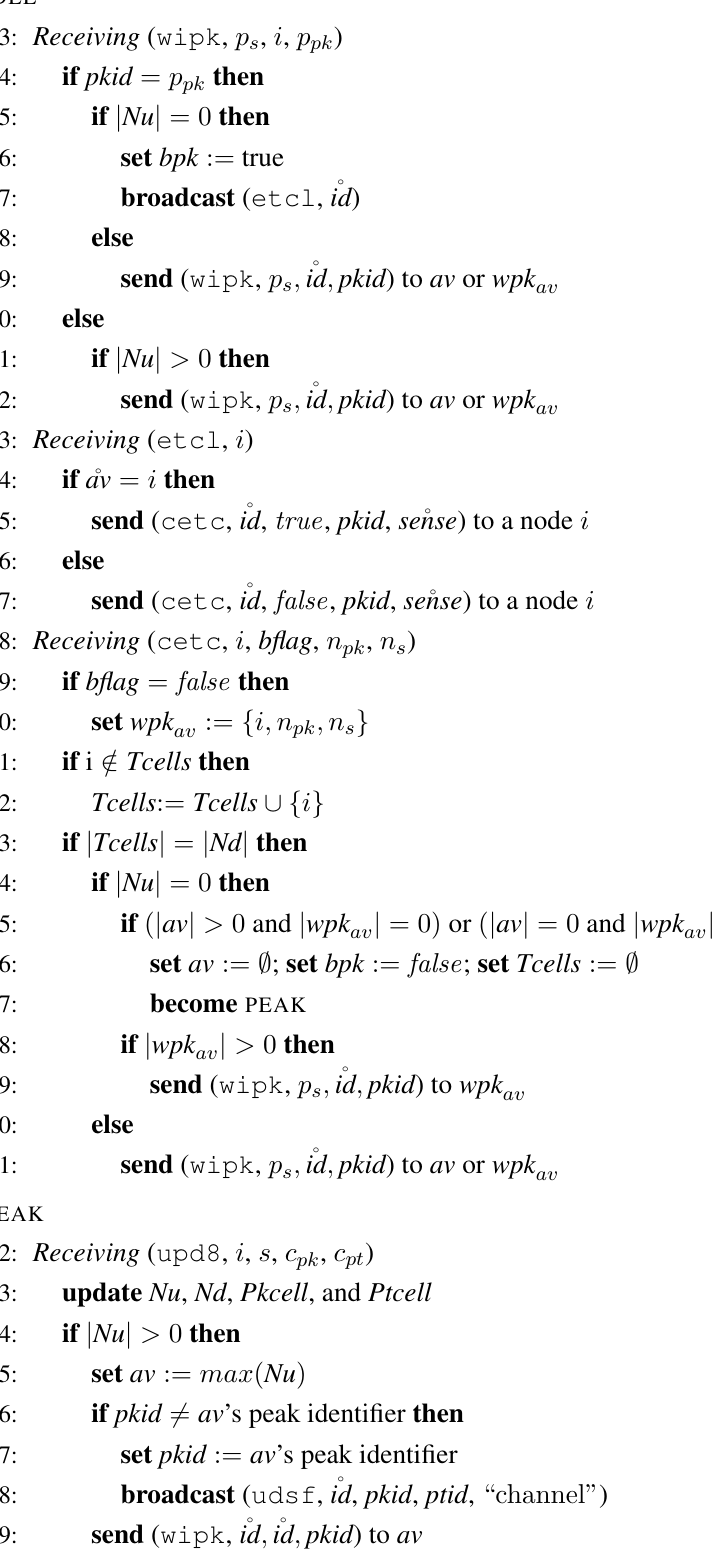
Algorithm 2 Monitoring a peak